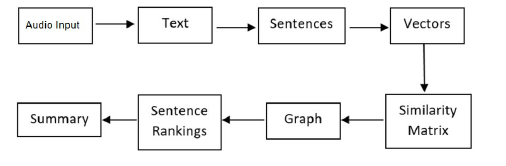
Figure 2. Flowchart